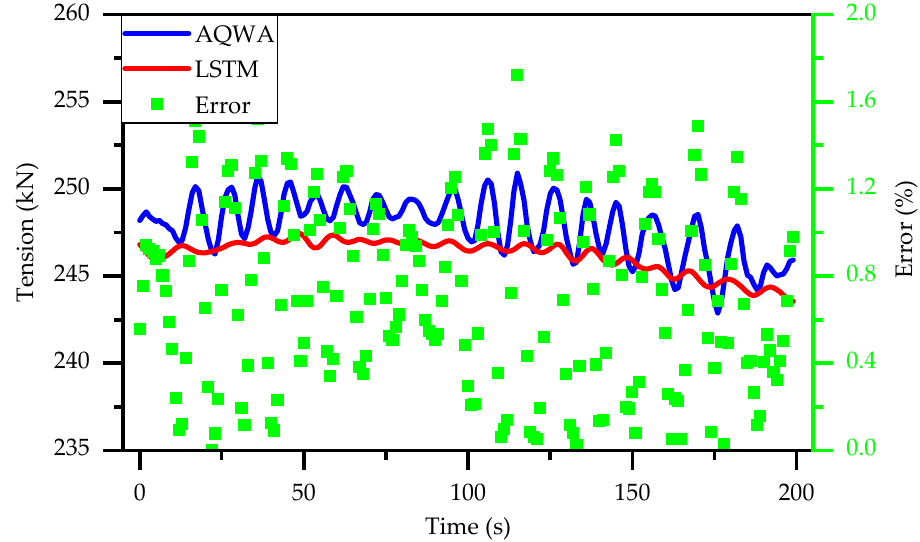
Figure 7. Error analysis of AD10 Mooring Line 8.